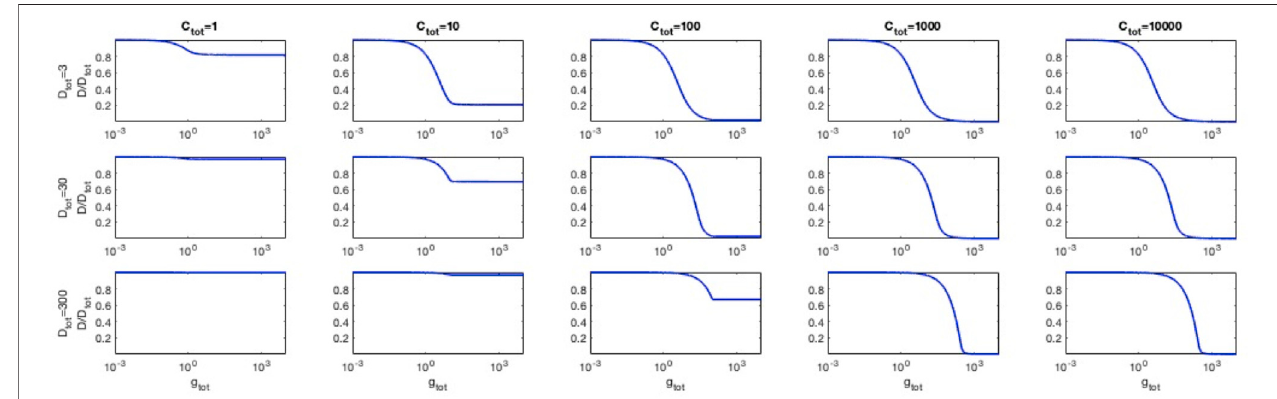
FIGURE2 | Mathematical model simulations ofcircuit output as afunction ofdCas9, sgRNA and targetpromoter DNA copy number.The output curves represent the intracellular concentration of free promoter DNA ( D ) normalized by the total concentration of available promoter DNA ( D tot ). The independent variable of the simulationsis theintracellularconcentrationofsgRNA ( g tot , expressed asnM concentration). Simulationsare shown for different values ofdCas9 ( C tot ,expressed asnM concentration, in the columns) and DNA ( D tot , expressed as nM concentration, in the rows). Parameters: K 1 (cid:2) 0.3 nM, K 2 (cid:2) 2